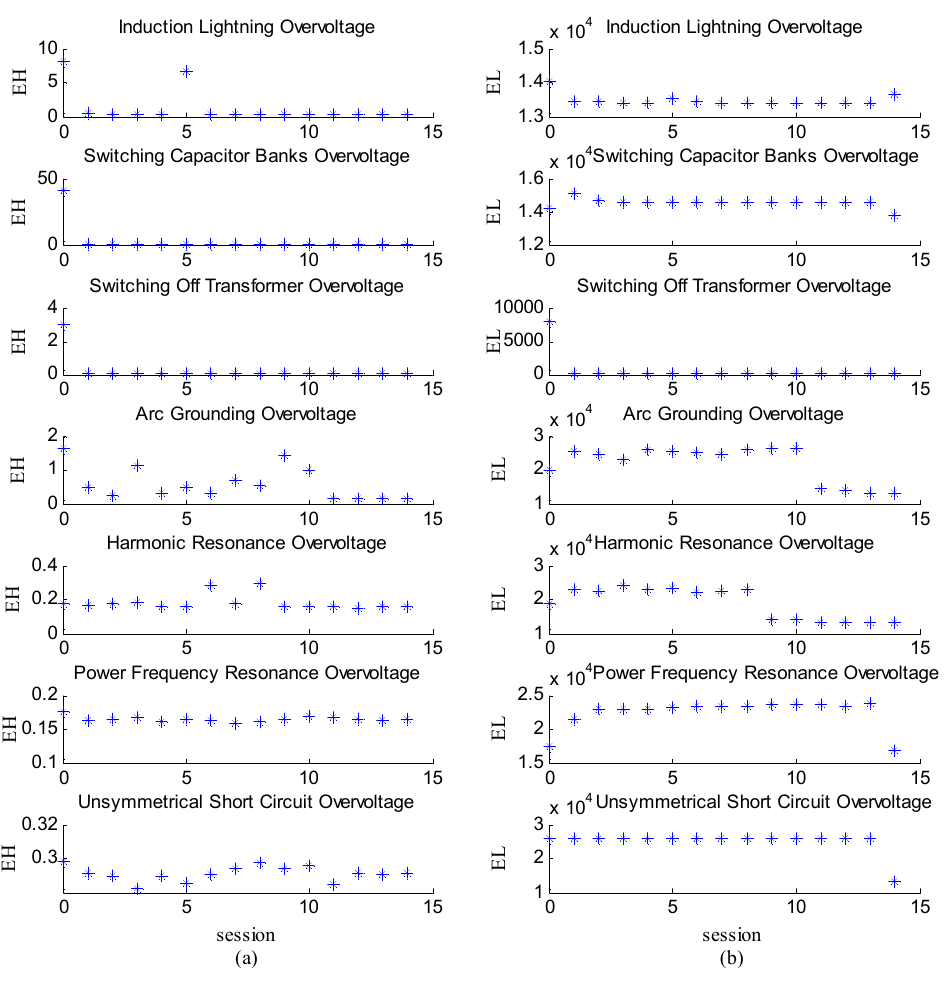
Figure 9. ( a ) EH(i) energy distribution series of di ff erent overvoltage; ( b ) EL(i) energy distribution series of di ff erent overvoltage.